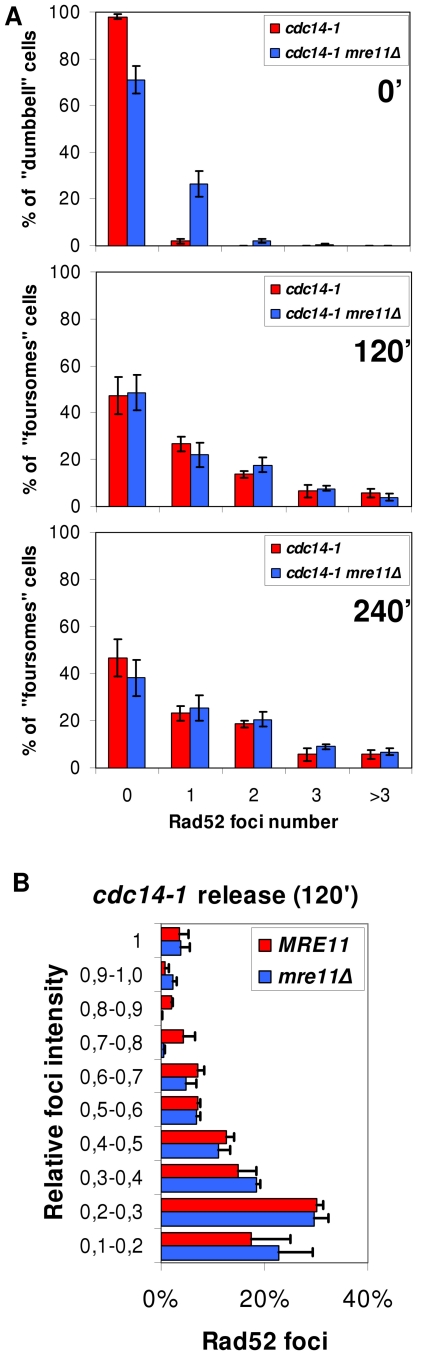
Accumulation of Rad52 foci after the cdc14-1 release is independent on Mre11.(A) Strains FM515 (cdc14-1 RAD52-YFP) and FM572 (cdc14-1 RAD52-YFP mre11Δ) were arrested at 37°C for 3 hours and then released at 25°C. Rad52 foci were counted in dumbbells at the telophase block (0′) and in foursomes 2 and 4 hours after the release (mean ± SEM, n = 3). (B) Intensity quantification of Rad52 foci in MRE11 and mre11Δ strains 2 hours after the release (see methods for details).